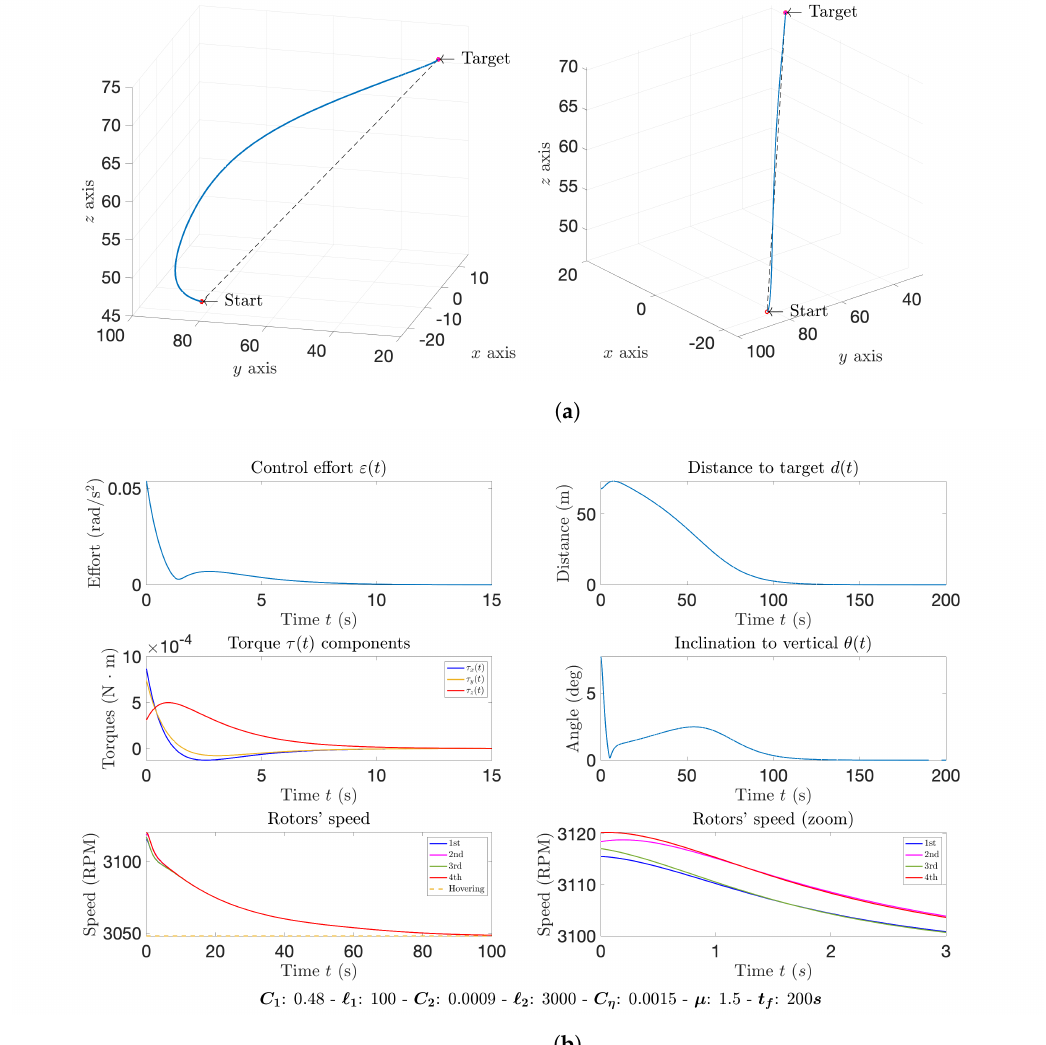
Figure 3. Experiment: Target point above the start point, random initial conditions. ( a ) Target approaching trajectory; ( b ) Control